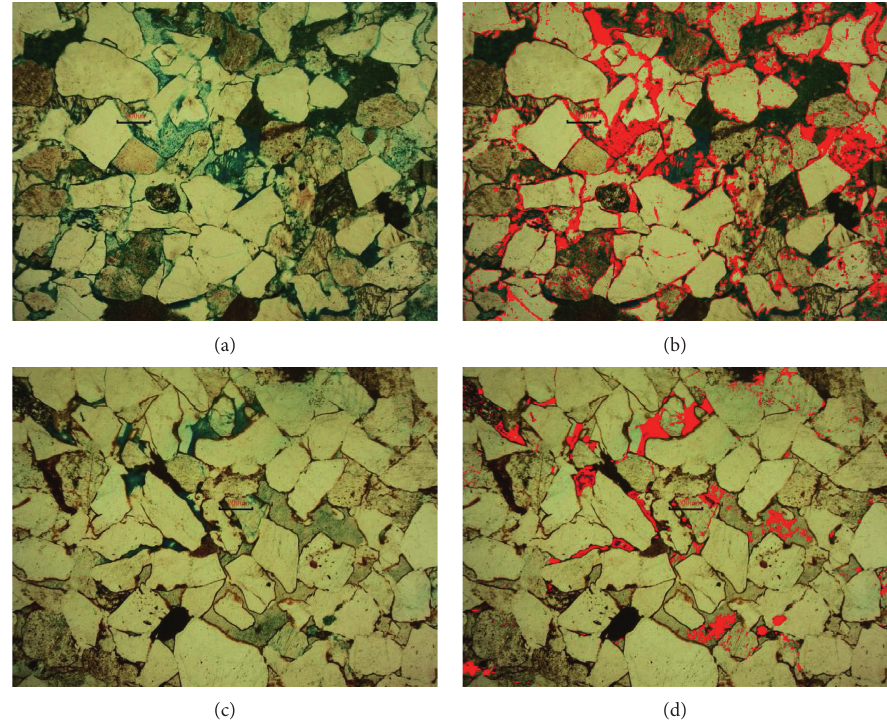
Figure 15: Photos of casting thin sections: (a, b) room temperature; (c, d) after treatment at 600 ° C. The red areas in panels (b) and (d) are the holes and cracks identified by ImageJ software corresponding to panels (a) and (c),